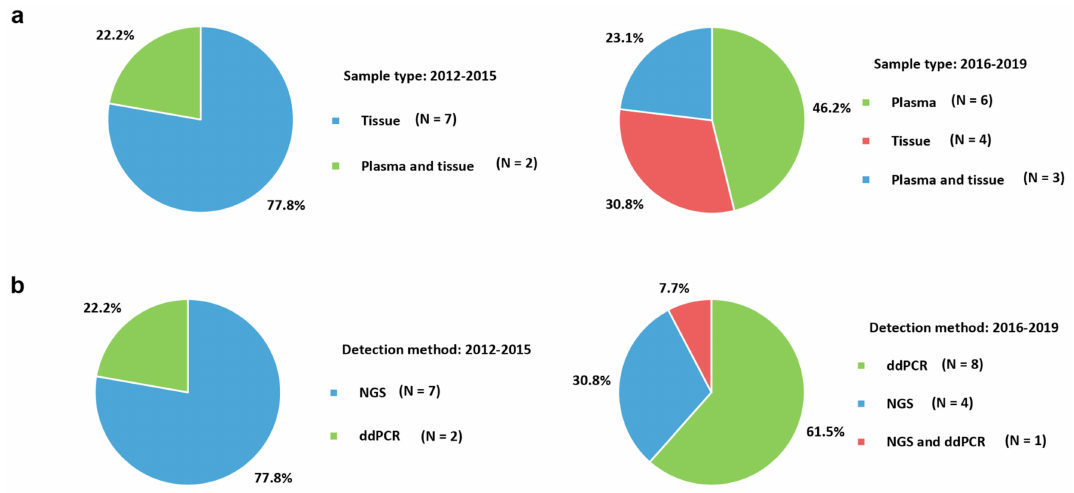
Figure 2. Changes in the application of molecular assays for detecting ESR1 mutations over time. ( a ) Pie charts showing the changes in the used sample types; ( b ) Pie charts showing the changes in the use of molecular detection assays. NGS, next-generation sequencing; ddPCR, droplet digital polymerase chain